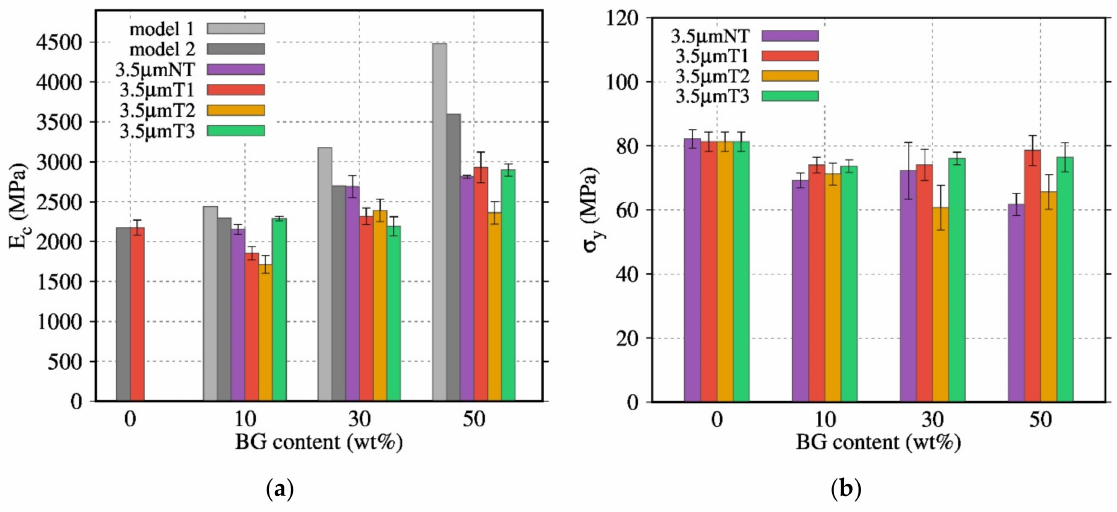
Figure 11. Evolution of ( a ) Ec (MPa), and ( b ) σ y(MPa) of composites based on BG 3.5 µ m NT with various thermal treatments as a function of the BG